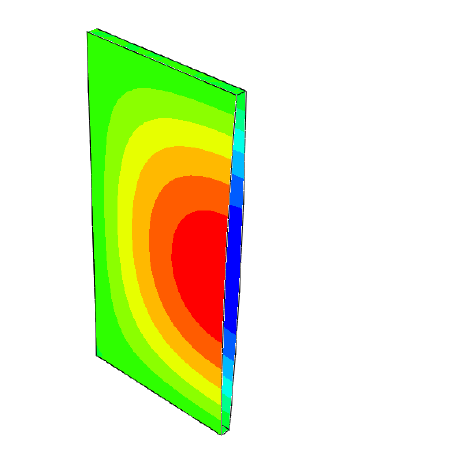
Figure 5. Deformations UZ [m] of the model in the case of injection of 100 mL of air (test series 2) to the gap.